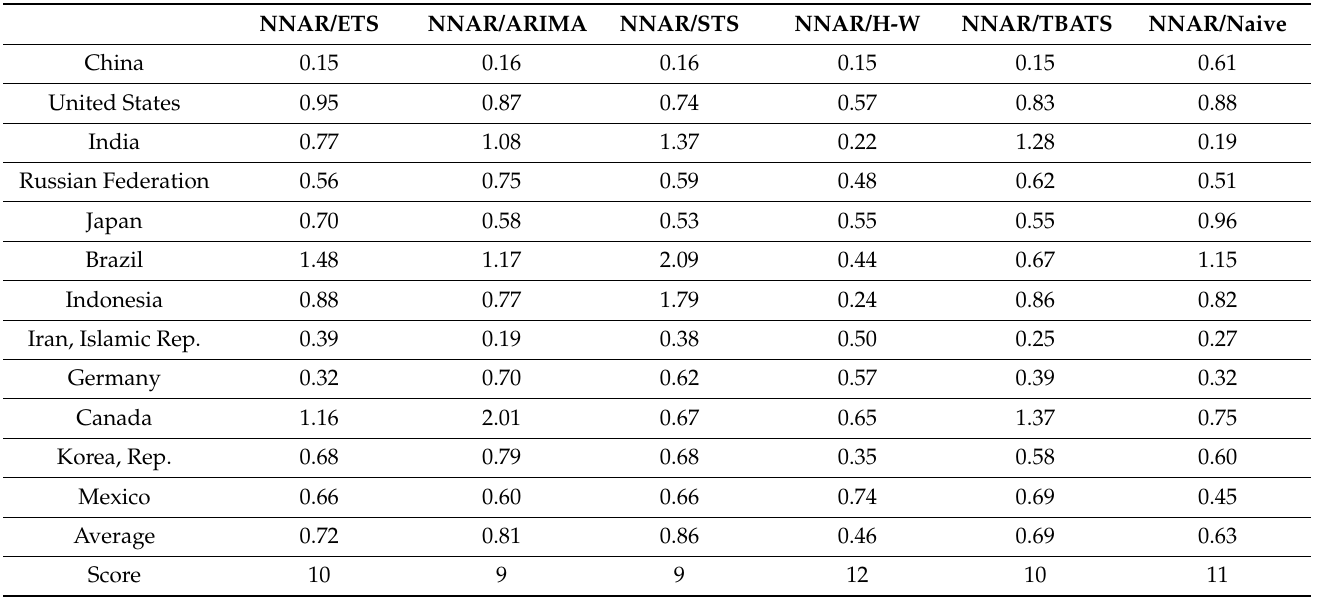
Table 3. RRMSE for out-of-sample forecasts of GHC emissions at h = 5 (O = M1/M2). NNAR/ETS NNAR/ARIMA